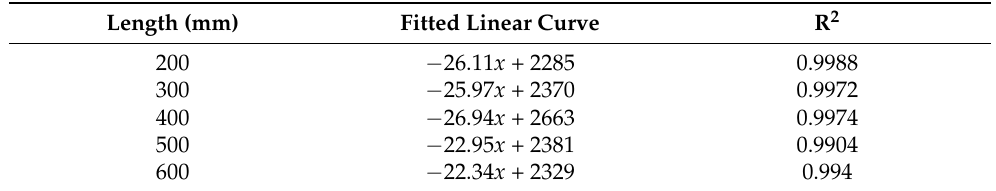
Table 5. Statistical model of the BCT values for sample boxes.